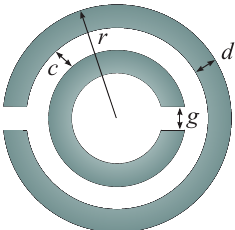
Figure 5: Geometry of the simulated EC-SRR, with r = 3.2 mm, c = 0.5 mm, d = 0.5 mm, and g = 0.5 mm. The periods